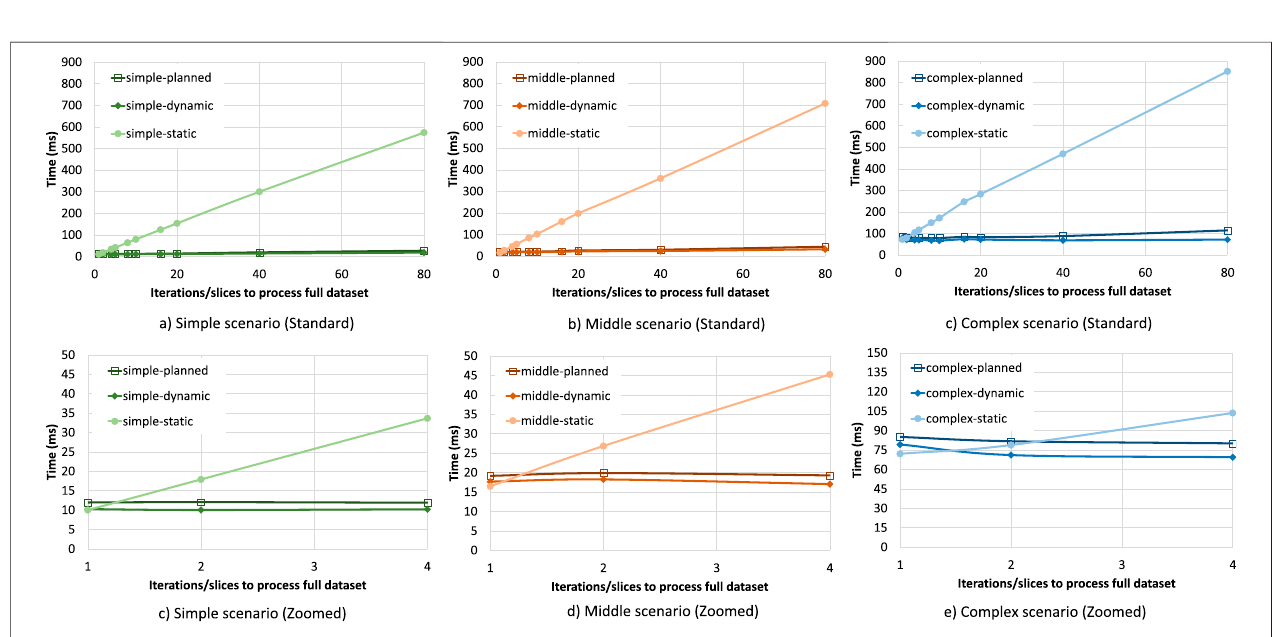
FIGURE10| Resultsoftherestartingexperimentperscenario.Thezoomedsub fi guresshowthebreakdownforeachscenario.Eachscenarioisgivenacolor,with the lightest, the mild, and darkest shades of each color representing the static , the dynamic , and the planned implementations, respectively. Iterations to process full dataset indicates the number of sections in the dataset. With one iteration, the entire dataset is processed without restarting, while with 80 iterations, the pipeline is restarted 79 times to process all data.